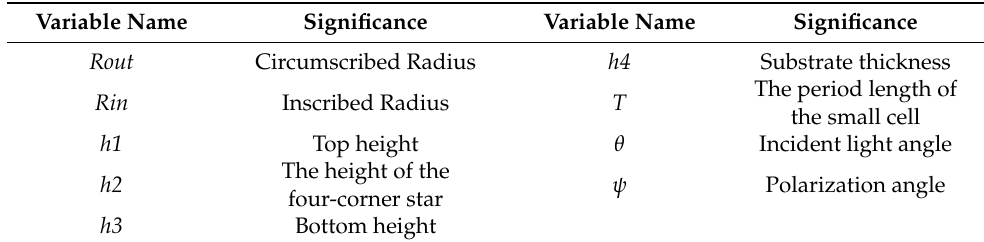
Table 1. Related parameters of the